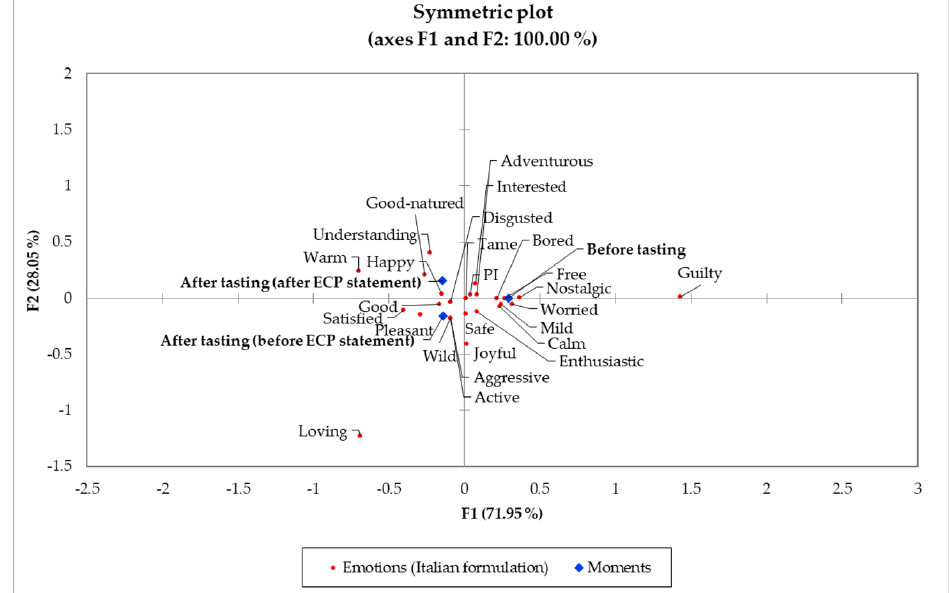
Figure 5. Correspondence analysis (chi-squared distance) symmetric plot visualizing the Italian treatment moments (before tasting, after tasting, and after edible cricket protein (ECP) statement) and emotions from n = 84 consumers. Treatments are described in Figure 1.